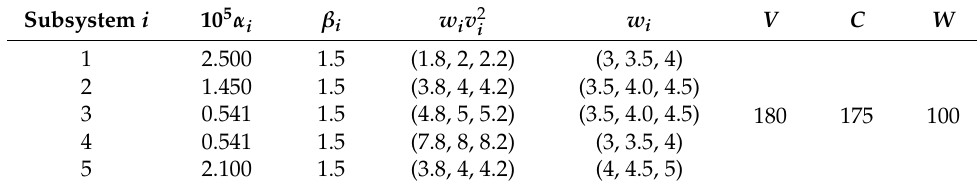
Table 2. Data for benchmark 2 [24,34,37].